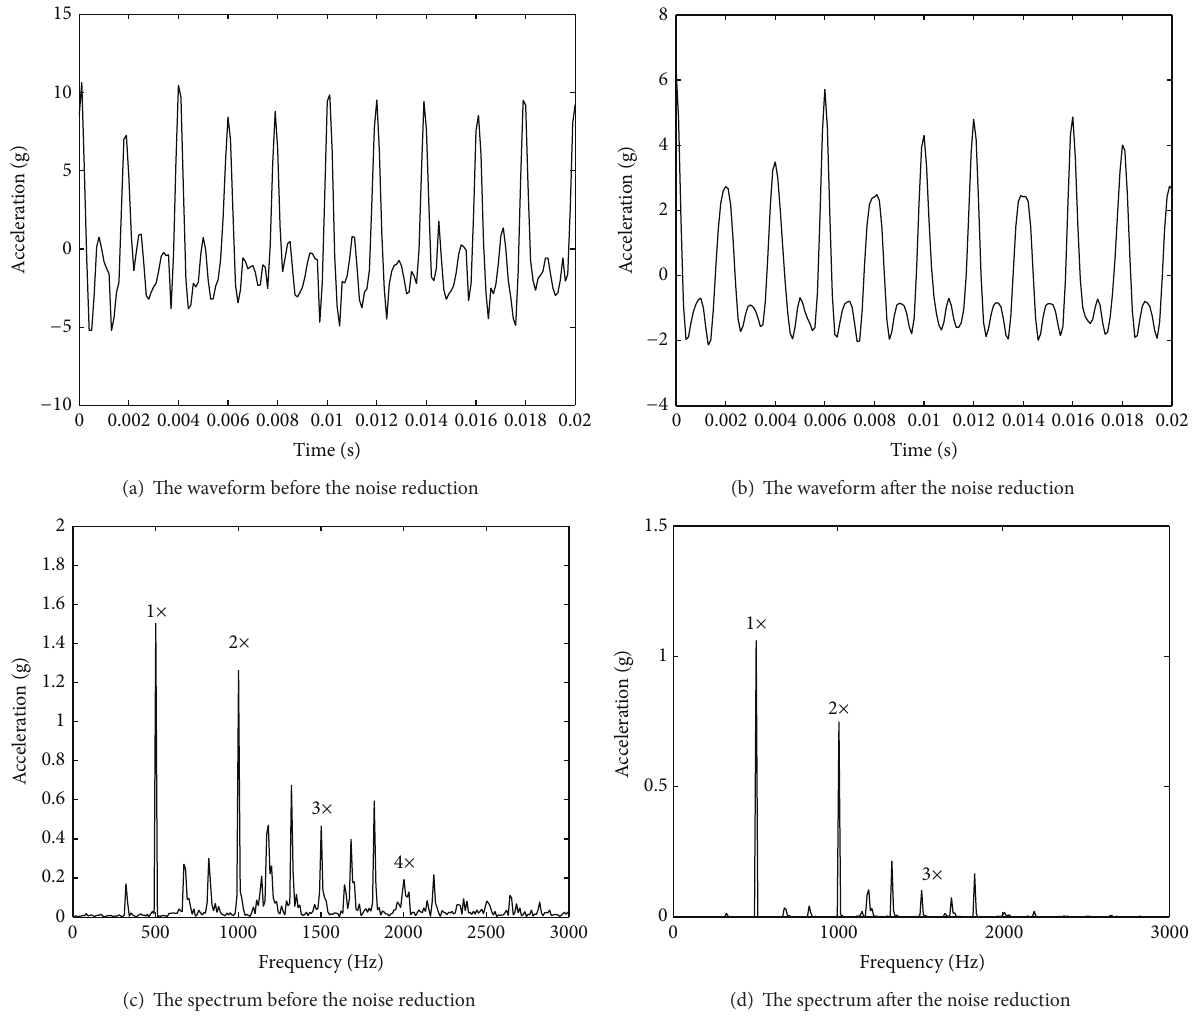
Figure 11: The time domain waveform and frequency spectrum before and after the noise reduction when the rotating speed is 30000 rpm.